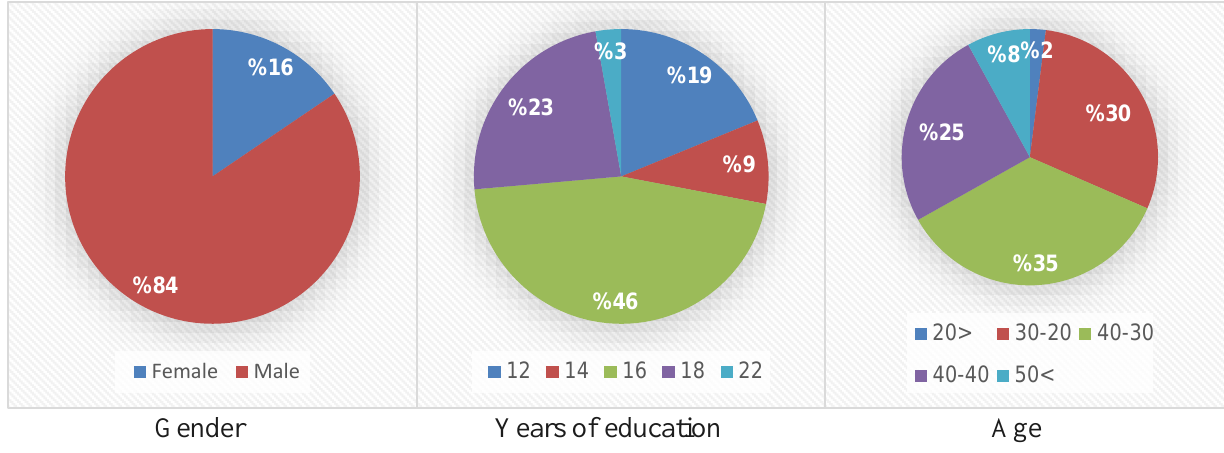
Fig. 1. Personal characteristics of the participants